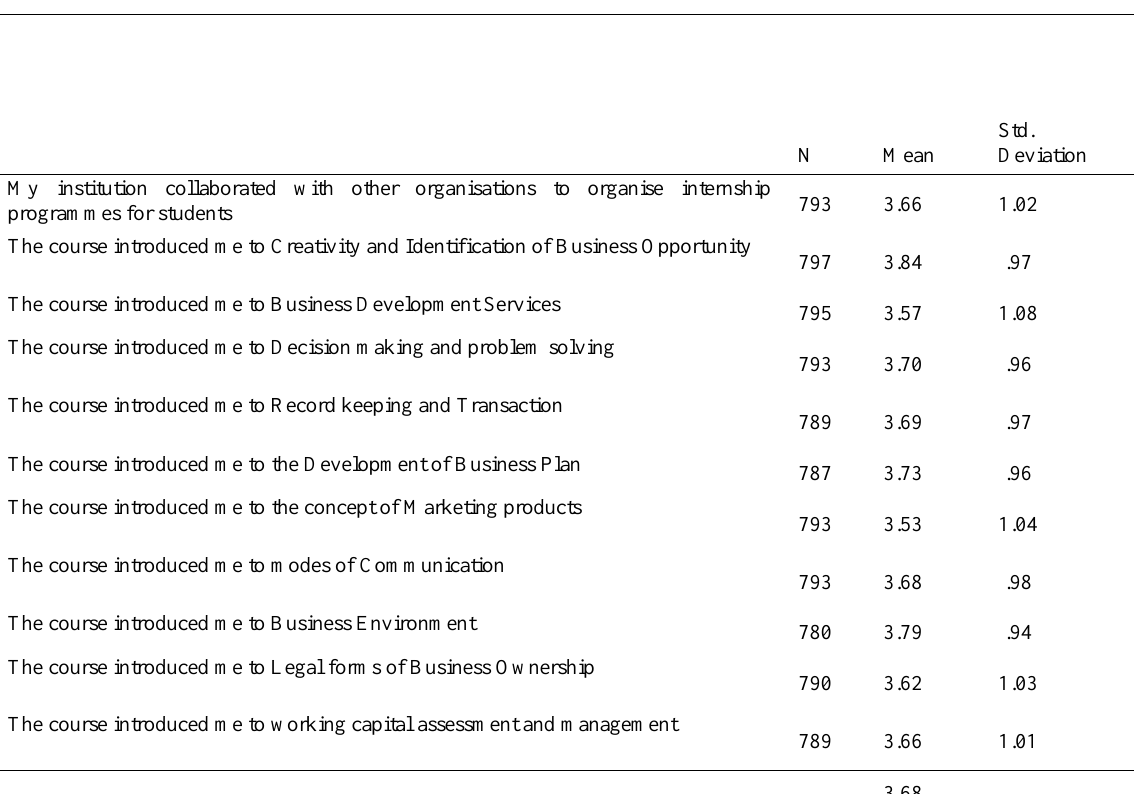
Table 2: Students and Graduates Ratings on Coverage of Entrepreneurial Course Content